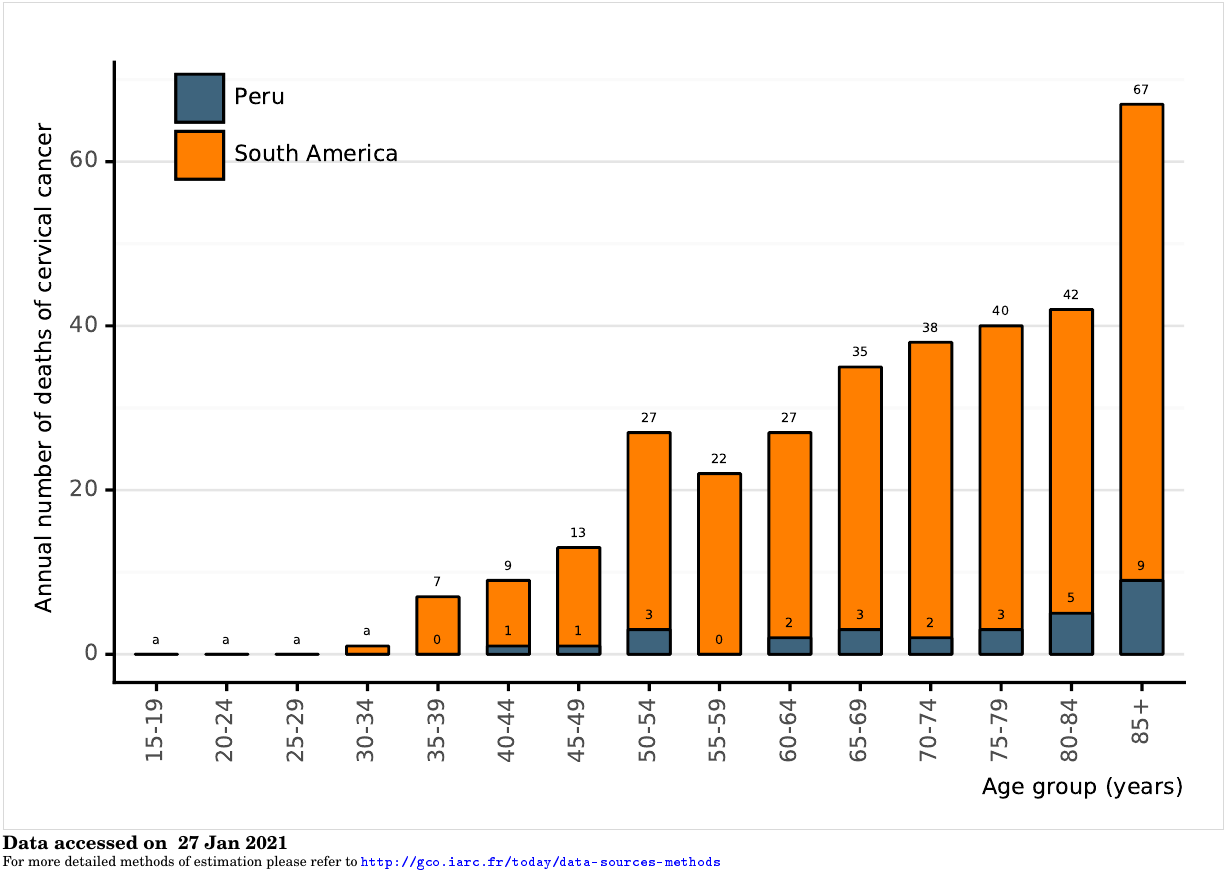
Figure 117: Annual number of deaths of cervical cancer by age group in Peru (estimates for